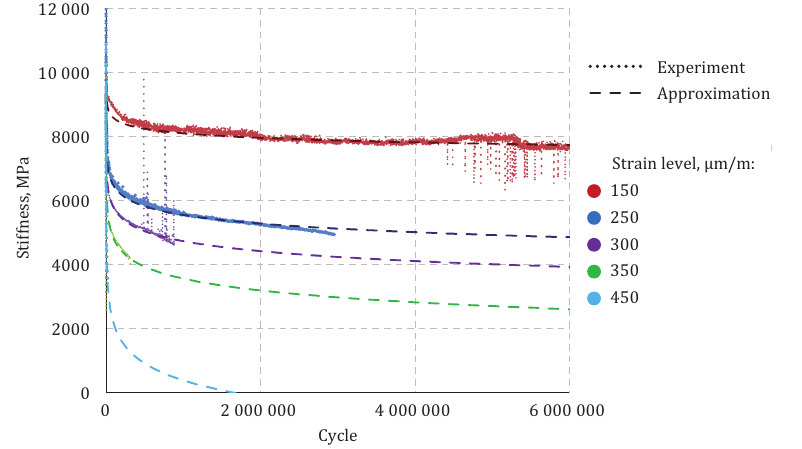
Figure 2. Fatigue curves of